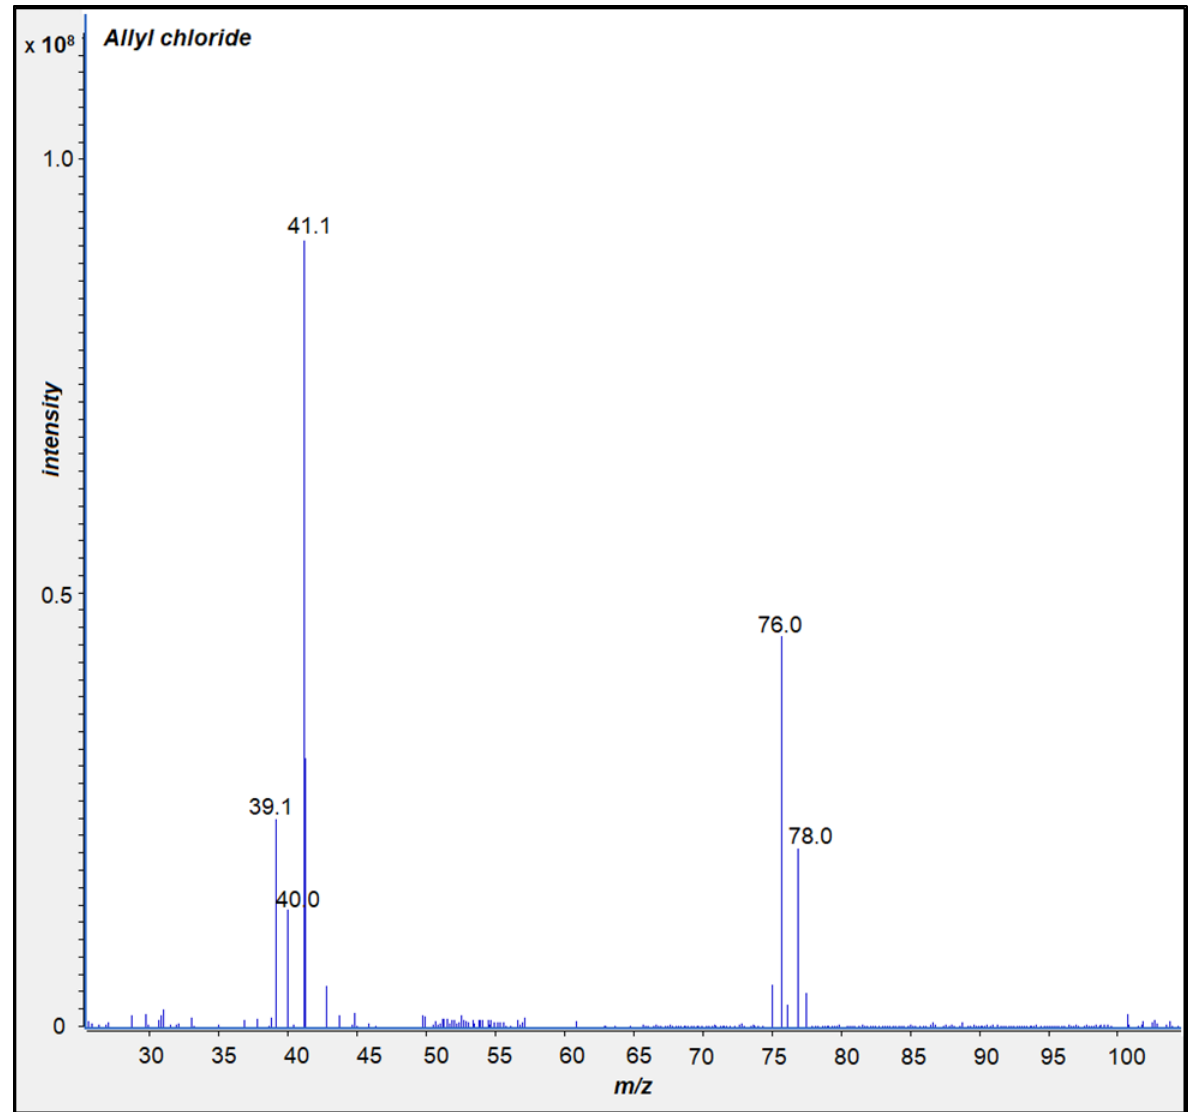
Figure 3. Mass fragmentation of allyl chloride.